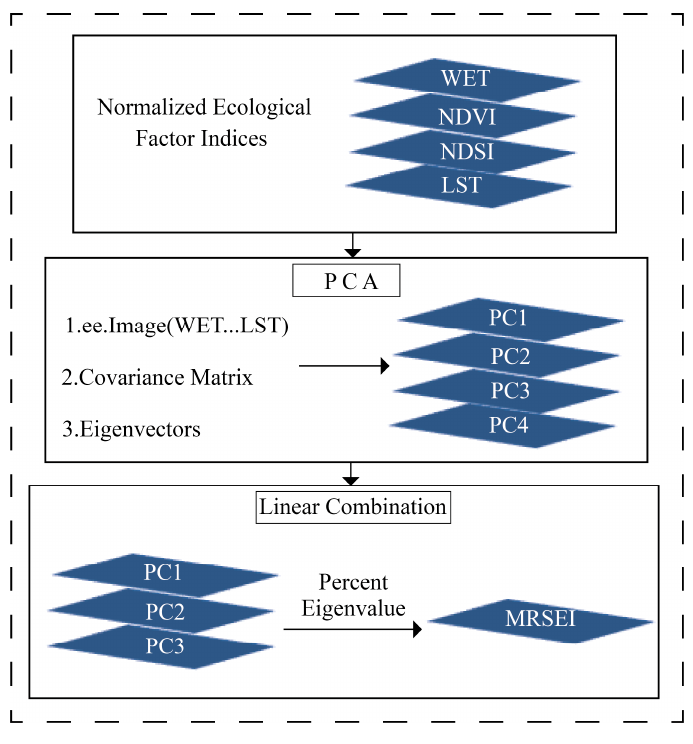
Figure 2. Flowchart of the derivation of the MRSEI.